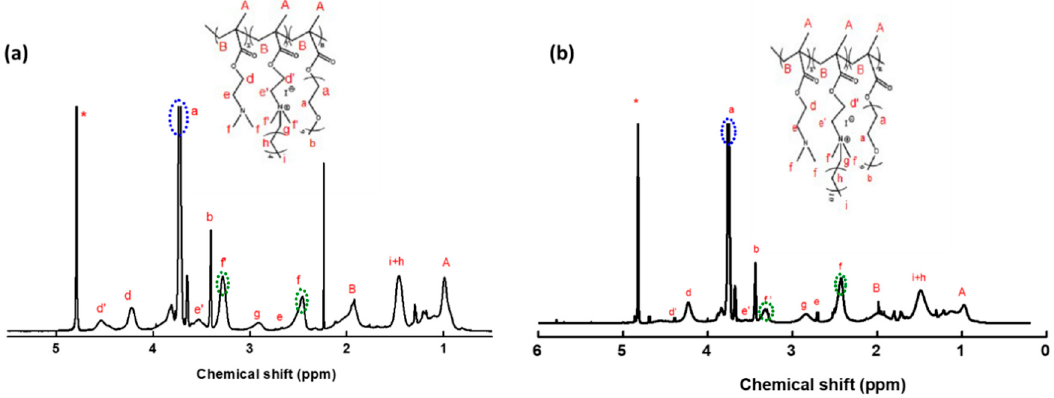
Figure 2. 1 H-NMR spectra for ( a ) P(DMAEMA-co-Q 6 DMAEMA)- b -POEGMA and ( b ) P(DMAEMA-co-Q 12 DMAEMA)- b - POEGMA in D 2